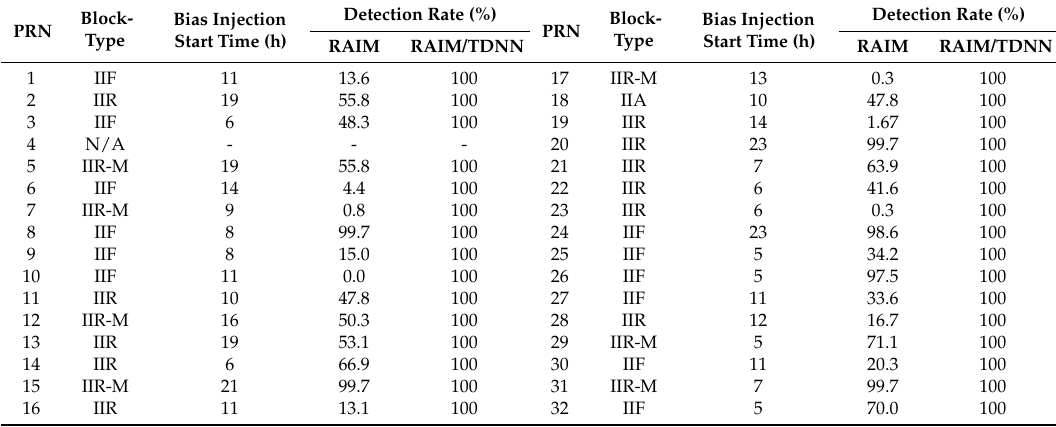
Figure 10. Performance comparison of anomaly detection schemes when a +100-m bias was alternately applied to all visible satellites from 1 p.m. to 2 p.m.: ( a ) RAIM and ( b ) RAIM/TDNN. Table 1. Detection rate when injecting a +150-m bias for an hour while changing the injection start time for all active satellites.